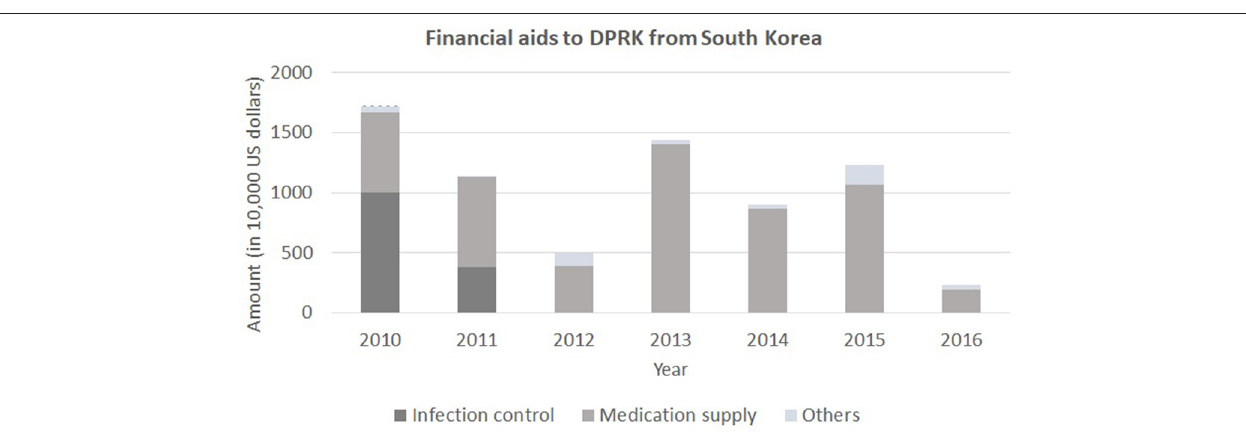
FIGURE 6 | Prevalence of anemia among non-pregnant women in the DPRK in comparison with the Republic of Korea and the nations of OECD between 1990 and 2015. Source: Stevens et al. (21).